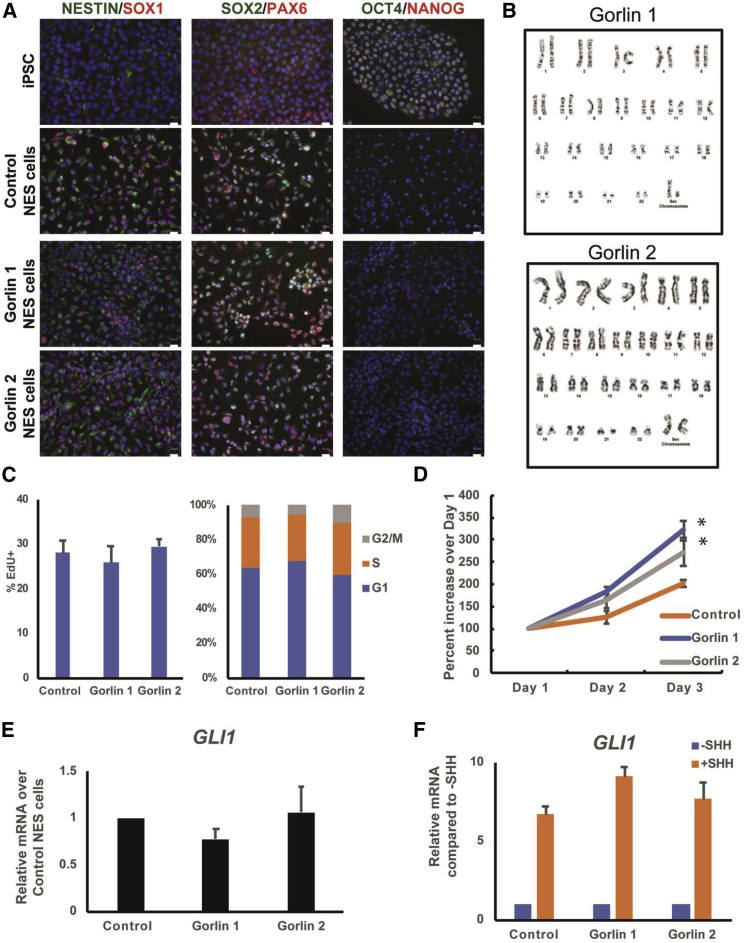
Gorlin NES Cells Display Neural Characteristics with Enhanced Proliferation and SHH Signaling(A) Similar to Control NES cells, Gorlin NES cells expressed NES cell-related markers (NESTIN, SOX1, SOX2, and PAX6), but not pluripotency markers (OCT4 and NANOG). Scale bars represent 20 μm.(B) Normal karyotypes for both Gorlin NES lines scored from 20 spreads each.(C) Control and Gorlin NES cells were treated with EdU for 1 h and analyzed by flow cytometry. No significant differences were seen in cell-cycle profile of each cell line. Data are presented as mean ± SEM.(D) CyQuant Direct cell proliferation assay of control and Gorlin NES cells show both Gorlin NES cell lines grew faster than control NES cells. Data are presented as mean ± SEM. ∗p < 0.05 (t test).(E) RT-qPCR quantitation of GLI1 mRNA expression in Control and Gorlin NES cells.(F) RT-qPCR quantitation of GLI1 mRNA expression in Control and Gorlin NES cells untreated or treated with SHH ligand (800 ng/mL) for 2 days. Gorlin 1 NES cells show modestly increased sensitivity to stimulation with SHH ligand compared with control NES cells. Data are presented as mean ± SEM.See also Figure S3 and Table S2.